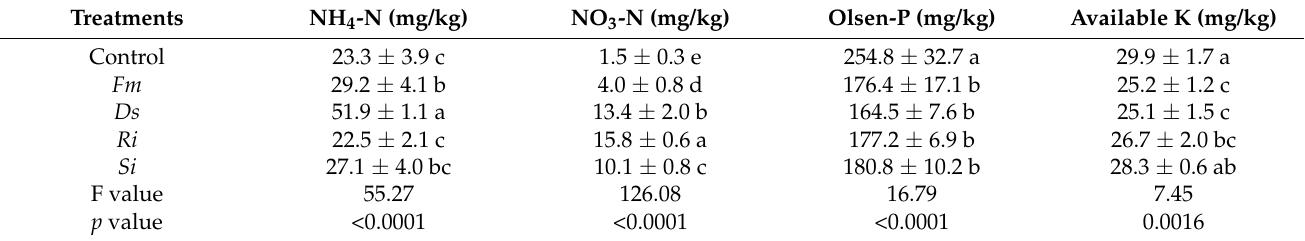
Table 4. Effect of inoculation with symbiotic fungi on soil chemical properties of Vicia villosa